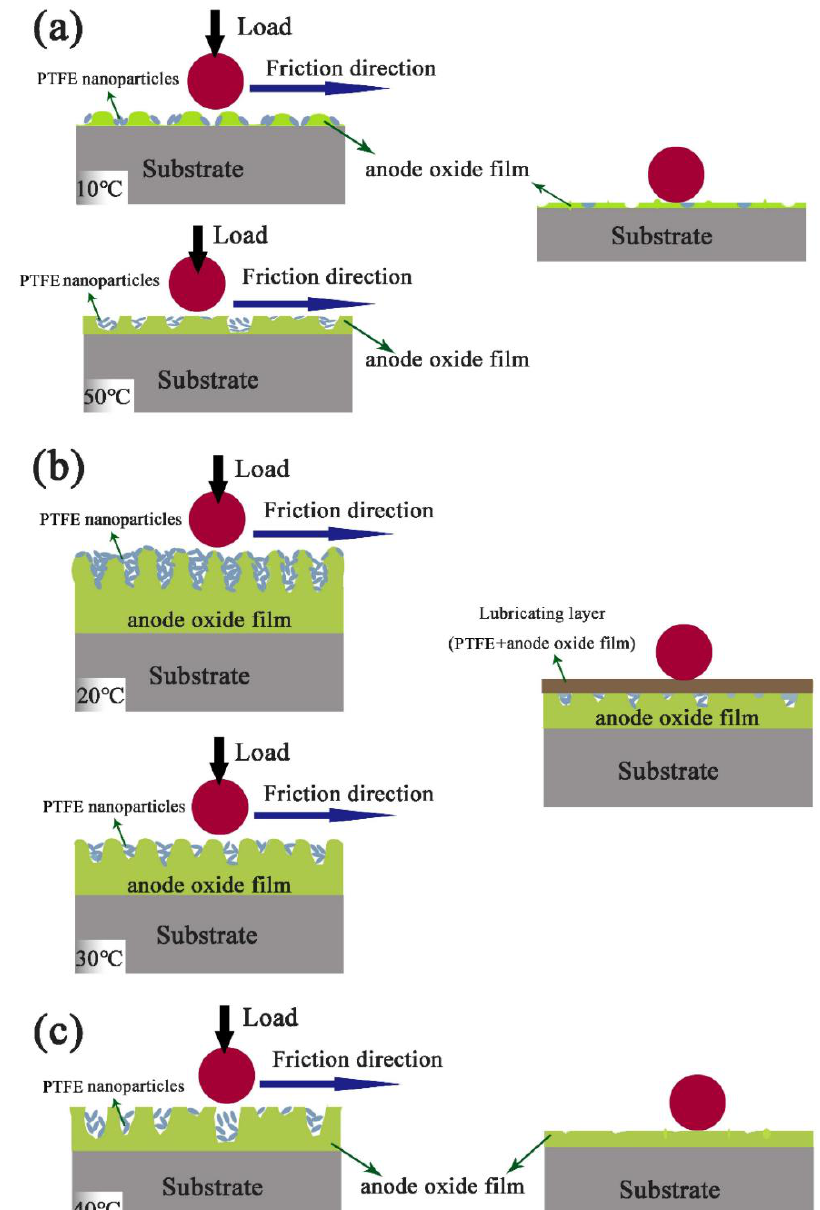
Figure 13. The corresponding lubrication mechanism of composite anodic films fabricated at different temperatures during the wear test. ( a ) 10 °C and 50 °C ( b ) 20 °C and 30 °C ( c ) 40 °C.